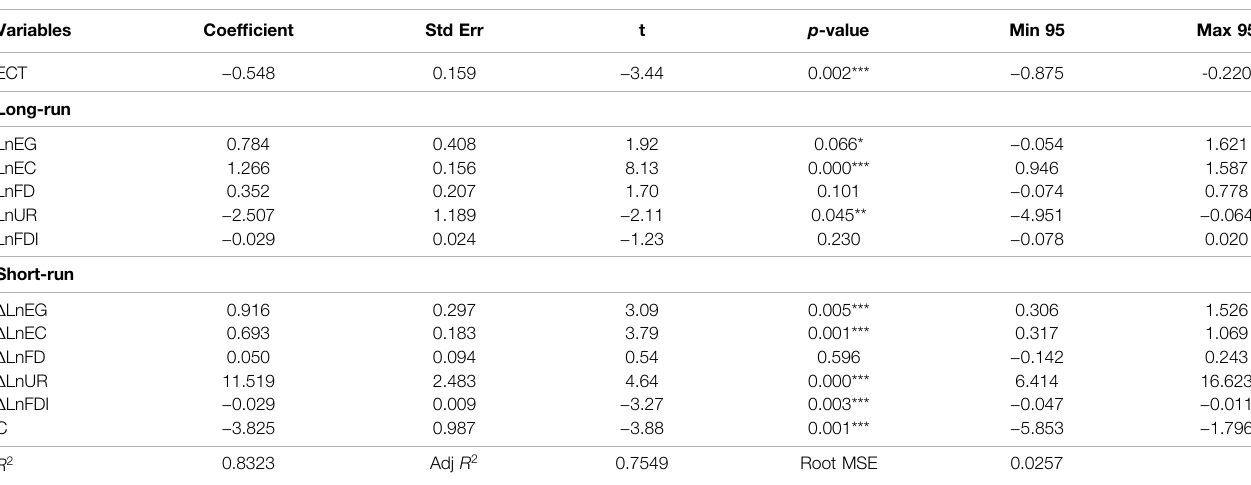
TABLE 3 | ARDL estimation